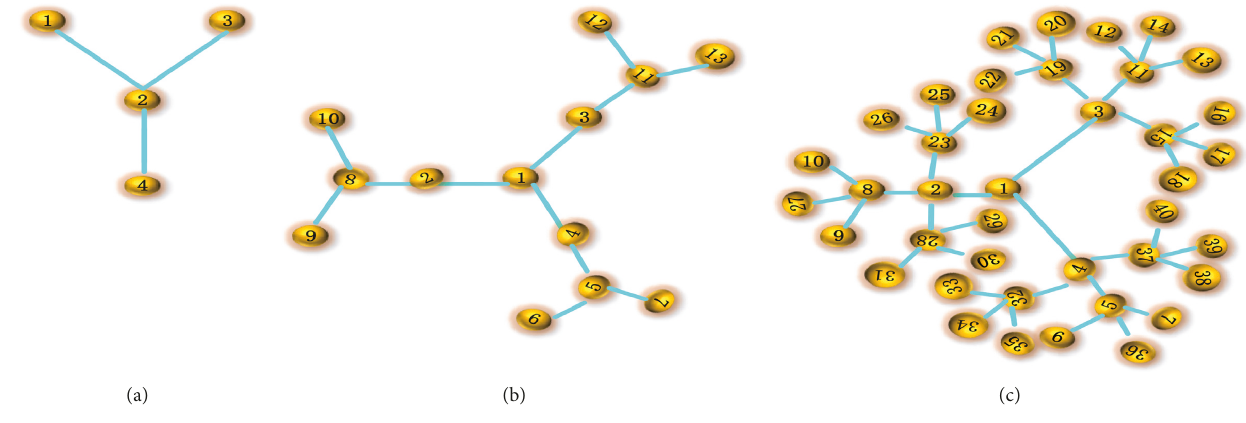
Figure 1: The process of constructing an